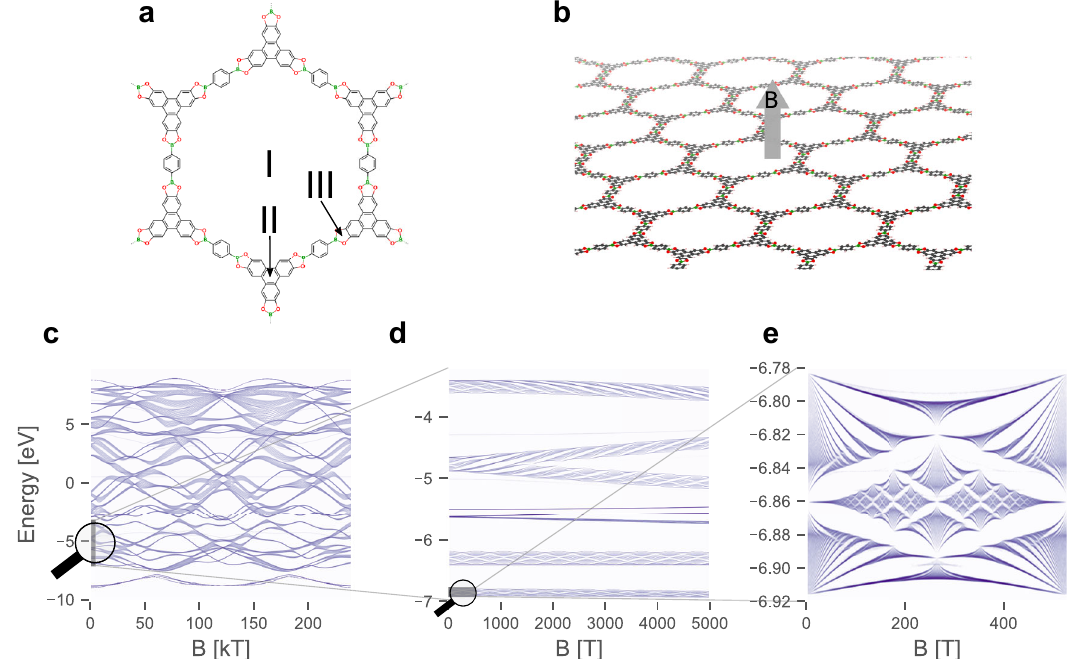
Fig. 2 Hierarchical periodic spectra for COF-5. a Structure of COF-5 including annotations for the largest to the smallest plaquettes (I – III). b Extended 2D structure of the honeycomb lattice of COF-5 with indicated applied magnetic fi eld. c Butter fl y spectrum from 0 to 240 kT. d Butter fl y spectrum from 0 to 5000 T. e Honeycomb HB from 0 to 530 T. The intensity of the DOS in the butter fl y spectra is depicted in a logarithmic scale although the colorbar was omitted for clarity.